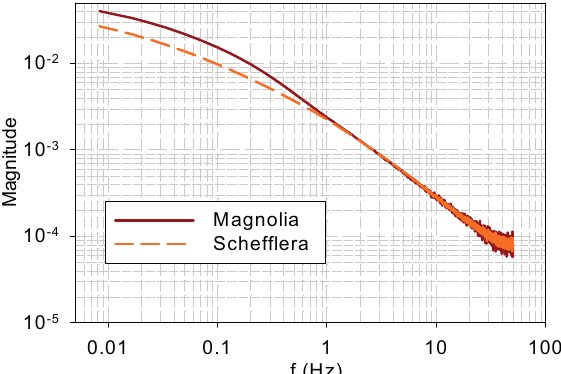
Figure 2. DF spectra for magnolia and Schefflera samples.